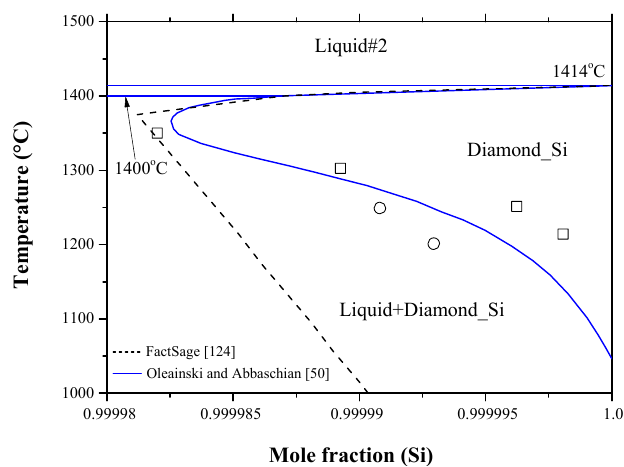
Figure 15. Magnified part of the Bi-Si system in the Si-rich side [50]; ----: [124]; ○ : [179]; □ : [118].